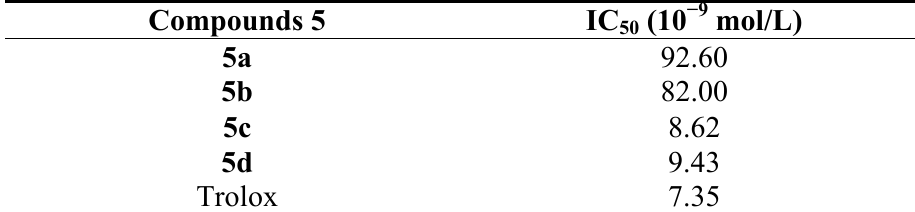
Table 4. Values of IC50 exhibited by coumarinic derivatives 5a – d